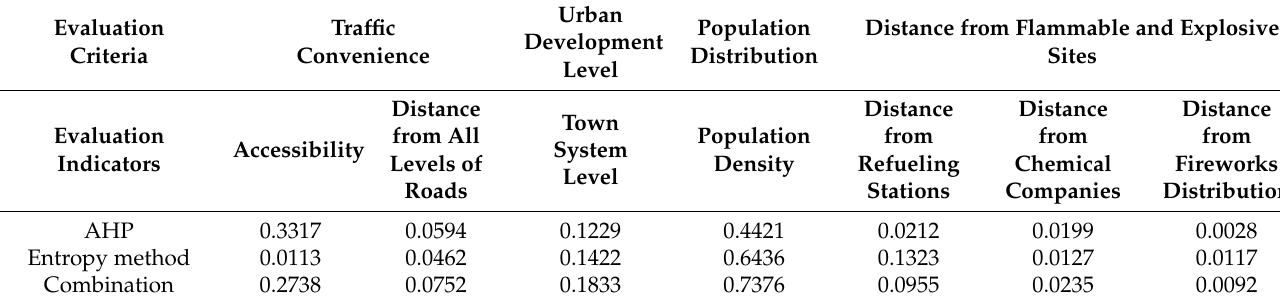
Table 3. Candidate location suitability evaluation indicators for medical facilities.